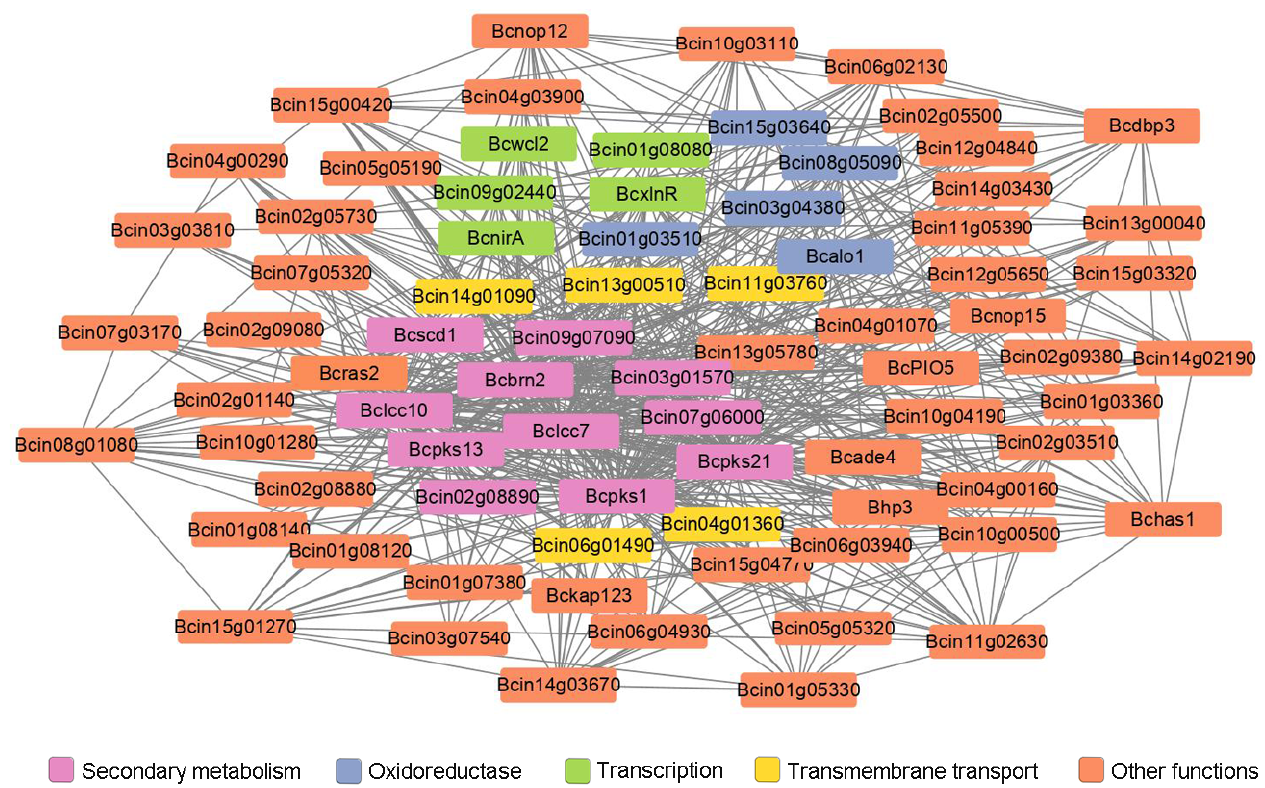
Figure 6. Co-expression analysis of differentially expressed genes in ∆ Bcras2 mutants. Genes highly co-expressed with Bcras2 were selected. Lines indicate genes co-expressed with a Pearson correlation coefficient of 0.99 or greater; p -adjust, 0.05; multiple test correction method: BH.